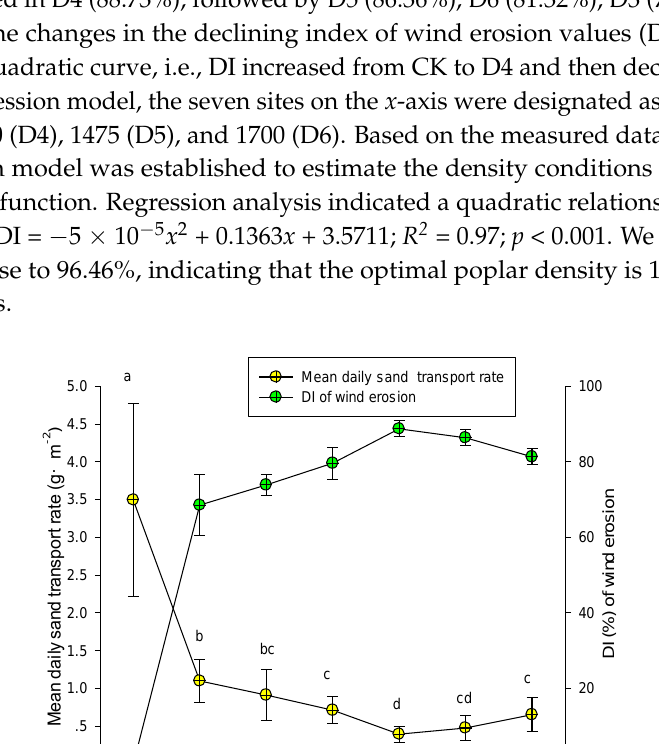
Figure 4. Variations in mean daily sand transport rate and the declining index (DI) of wind erosion. Means with different letters indicate significant differences at p < 0.05. Vertical bars represent ± standard deviation.